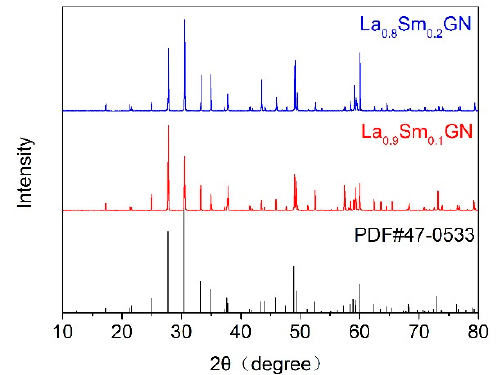
Figure 2. The X-ray diffraction (XRD) patterns of the Sm:LGN crystals.